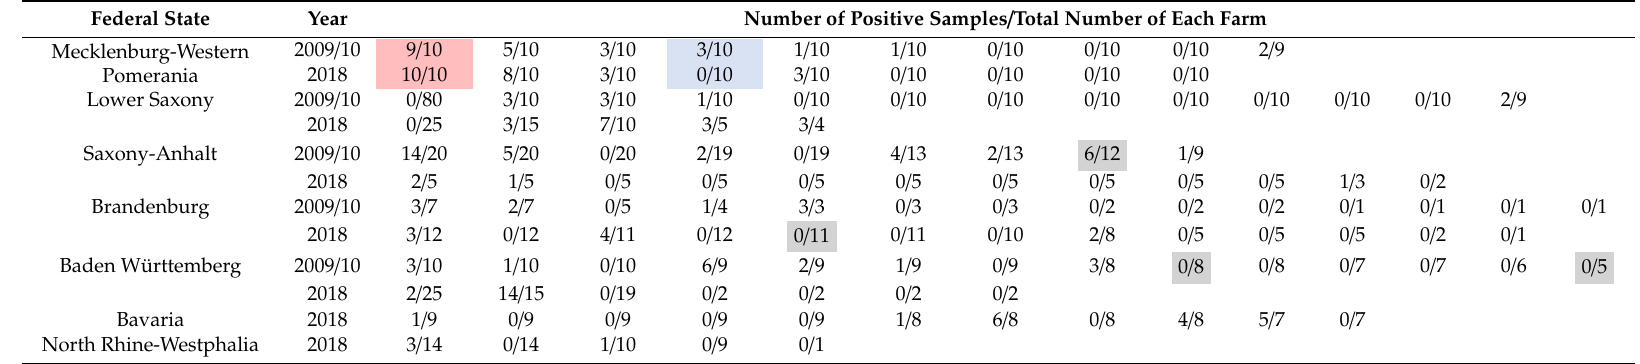
Table 2. Number of animals that tested positive for antibodies against APPV in relation to overall tested animals of each farm sorted by year and German federal state. Both of the farms that were sampled at both time points are marked by color shading, one in red and the other one in blue. Farms, where viral RNA of APPV was detected by RT-PCR testing in at least one animal, are shaded in